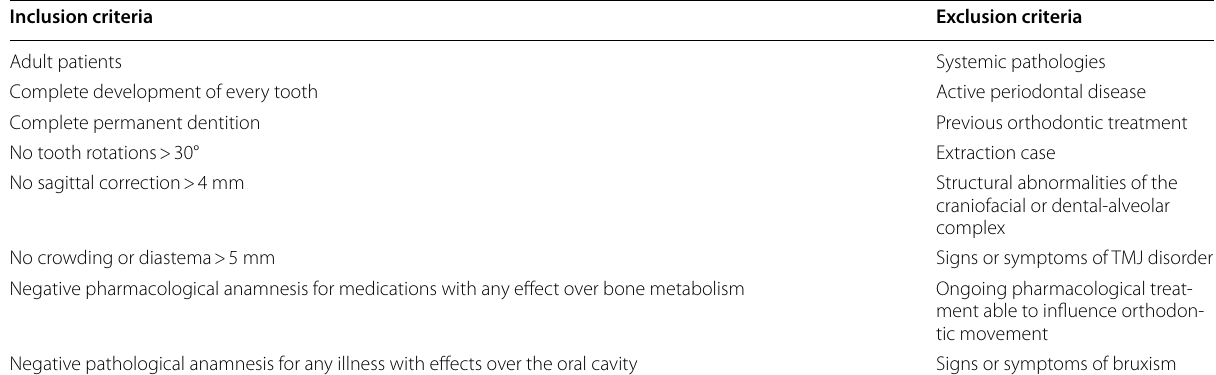
Table 1 Criteria for participant’s selection or exclusion Inclusion criteria